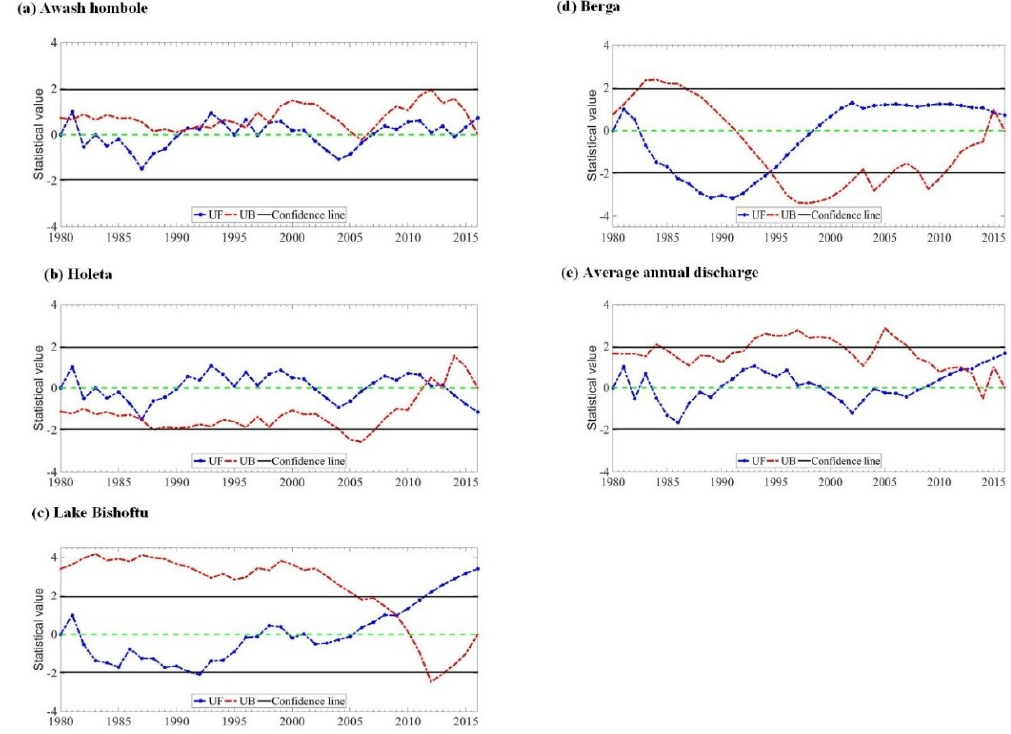
Figure 4. Trends of annual discharge across stations (note: U B = −U F ).